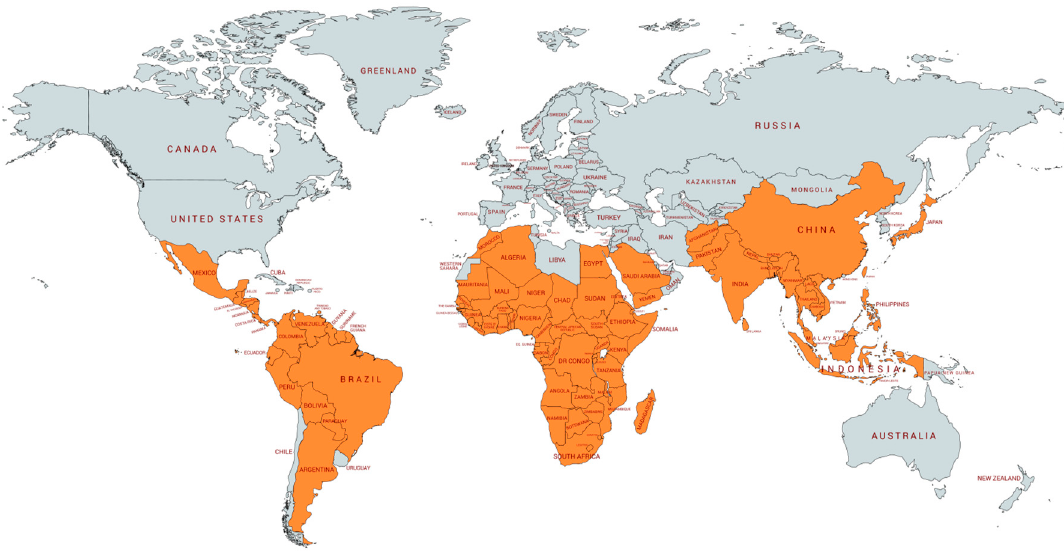
Figure 1. Global primate distribution. In orange, countries with native species of primates. Data were extracted from IUCN / SSC Primate Specialist group web site www.primate-sg.org / threat_primate_habitat_country / on August 15th. Graph art was generated using mapchart.net.